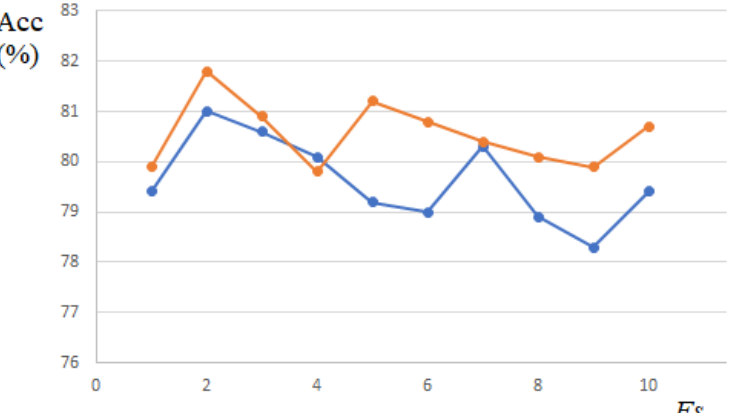
Figure 5. Testing accuracy obtained by different filter sizes apart from 150 filters of size 2, for English ( red ) and Italian ( blue ).